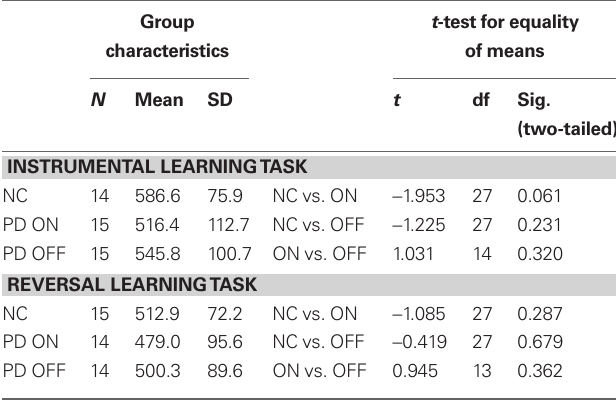
Table 5 | Mean reaction times and t -test results for the reward-based learning tasks in healthy controls (NC) and PD patients on levodopa (ON) and off levodopa